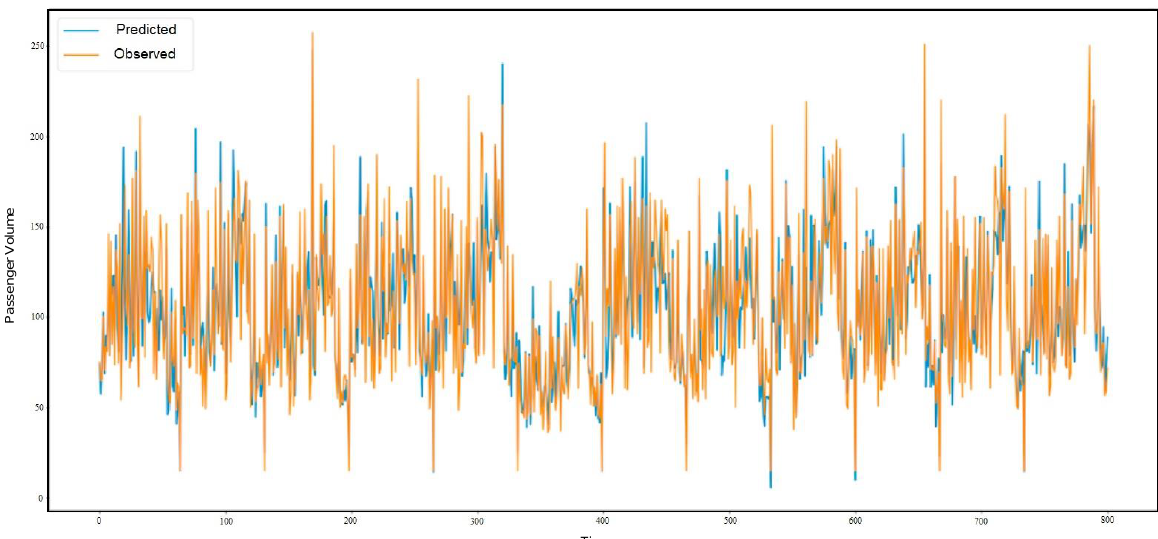
Figure 13. The 15-min prediction